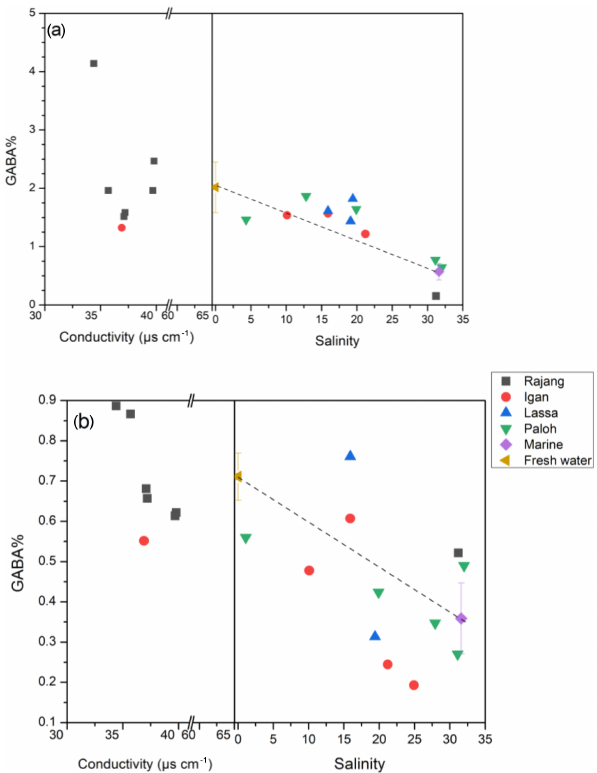
Figure 4. The GABA percentage distribution pattern from fresh water to the estuary in the Rajang: (a) dissolved and (b) particu- late. Note the different x -axis scales between plots (a) and (b) . The dashed line indicates the linear mixing line between freshwater and marine endmembers. The freshwater endmember (brown triangle) was calculated as the mean of all freshwater samples (salinity 0), and the marine endmember (purple diamond) was calculated as the mean of all offshore samples with salinity > 30. The error bar indi- cates the standard deviation.